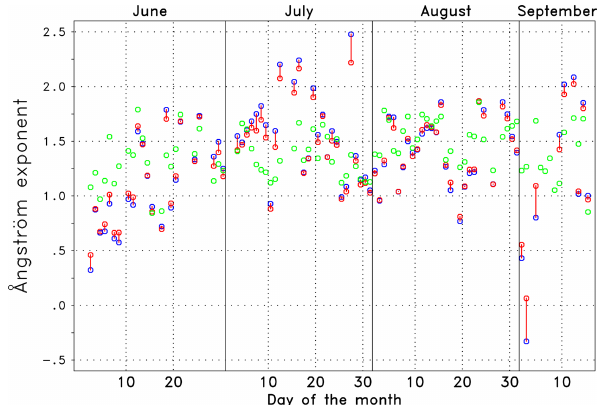
Figure 4. Angström exponent (daily averages) for the spectral range 1020–1640nm (blue, κ n ) and 870–1640nm (red, κ w ), connected by a vertical line. For comparison the standard AERONET output for 440–870nm (green, κ a ) is